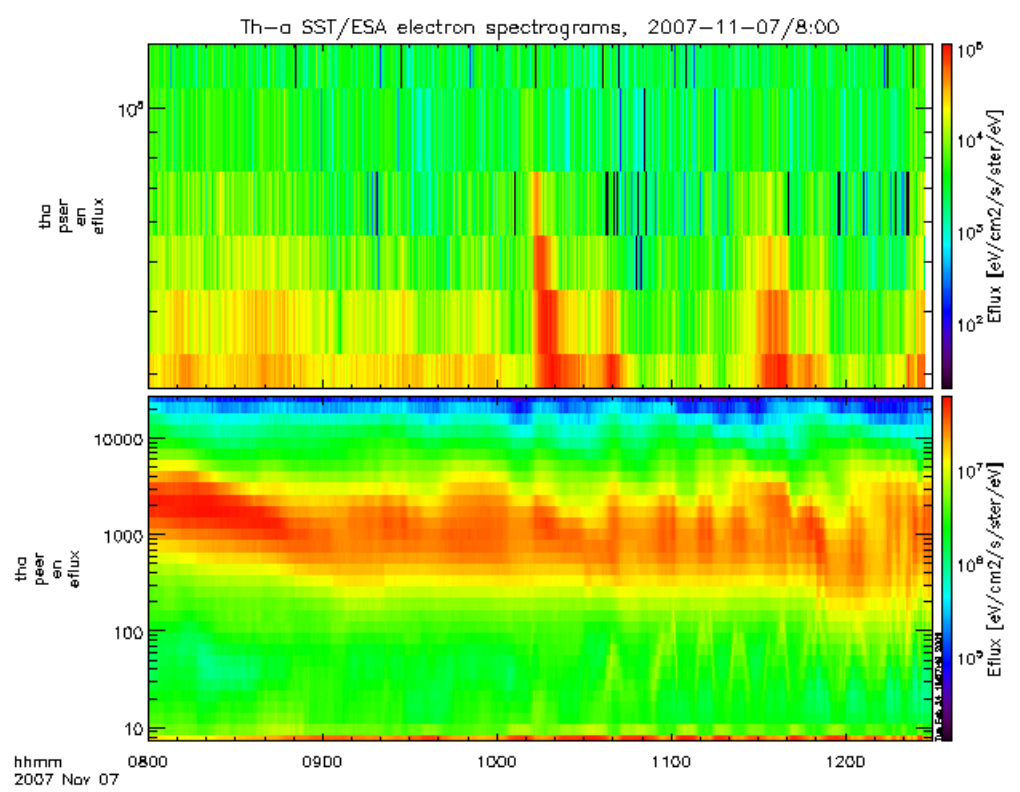
Fig. 6. Energy flux spectrograms for electrons in the range of energies from 2eV to 25keV (ESA) and from 25keV to 150keV (SST) on 7 November 2007 for